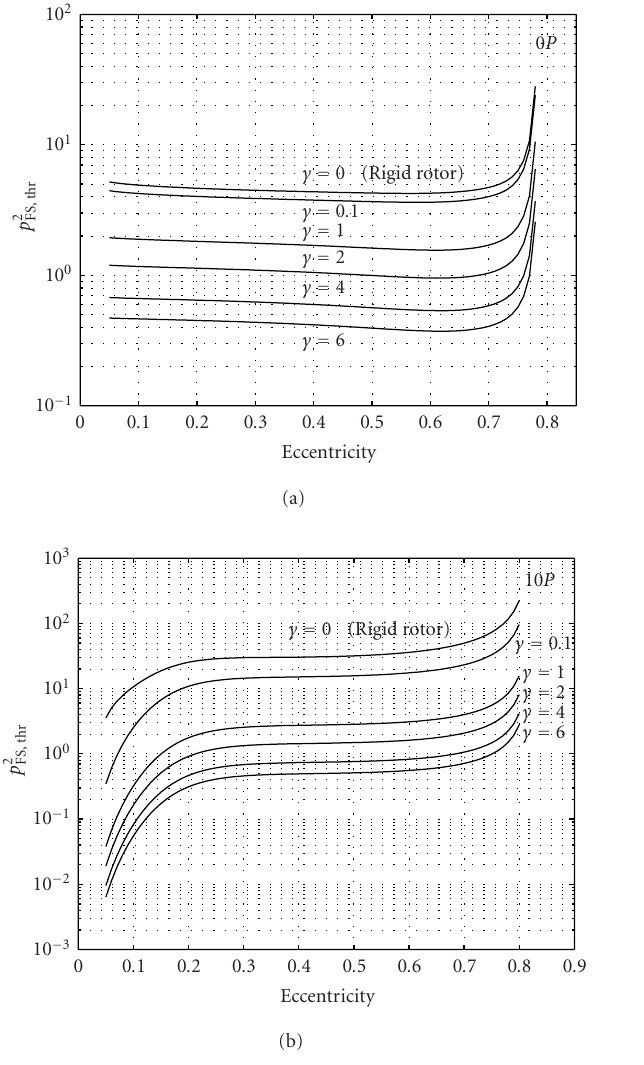
Figure 6: Steady state imbalance response of a Je ff cott rotor sup- Figure 5: Stability threshold curves p 2 for di ff erent shaft flexibil- ported on hybrid bearing trespassing the critical speed: (a) semi- FS,thr ities γ : (a) conventional circular bearing (0 P , infinitely long bearing flexible shaft and (b) flexible shaft with γ equal to half of the case coe ffi cients) and (b) hybrid, for pressure supply P s = 10.